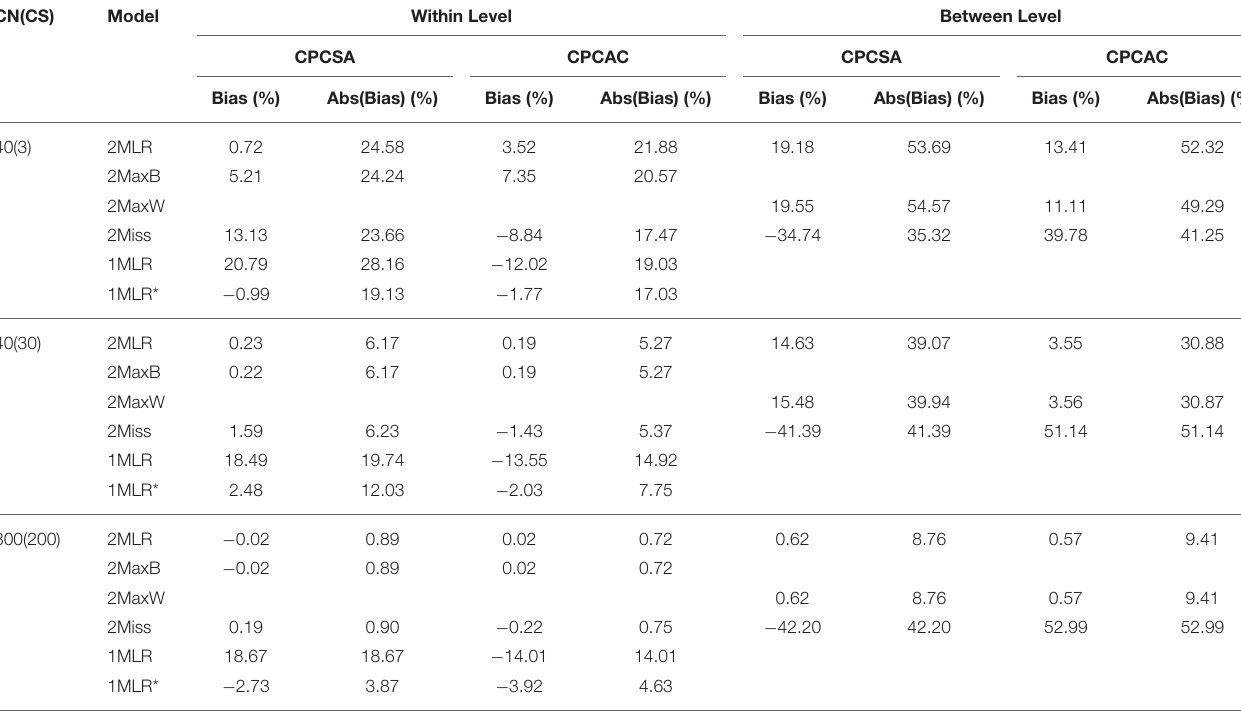
TABLE 4 | The relative bias and absolute bias of factor loading estimates from five SEM modeling techniques for ICC = 0.3. CN(CS) Model Within Level Between Level CPCSA CPCAC CPCSA